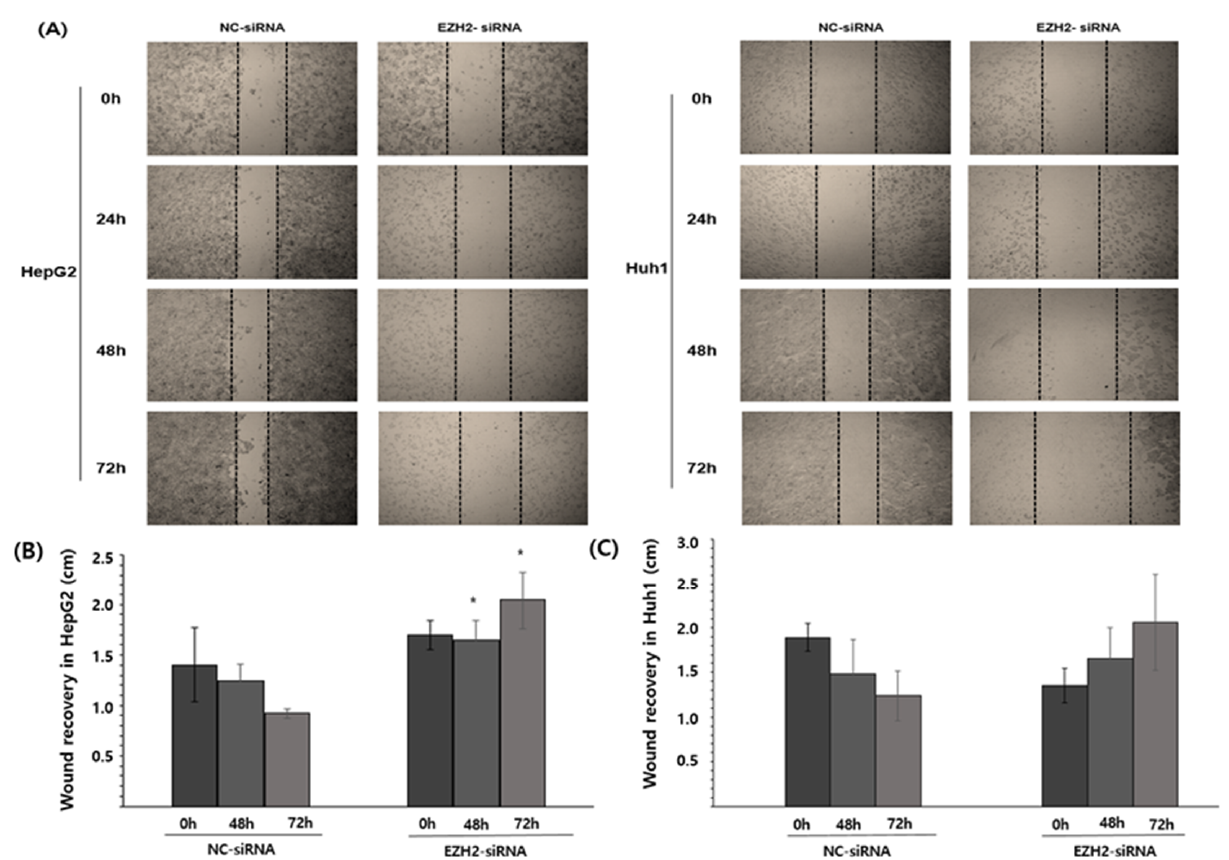
Figure 4. Cells migration in cell scratch wound healing assay. EZH2 inhibited cell migration in HepG2. ( A ) Wound healing assay of HepG2 and Huh1 upon (200 nM) for 24 h, 48 h, and 72 h. The HCCs treated with NC-siRNA were used as control. ( B ) Quantification of wound area in control and EZH2 treated HepG2. ( C ) Quantification of wound area in control and EZH2 treated Huh1. * p < 0.05.